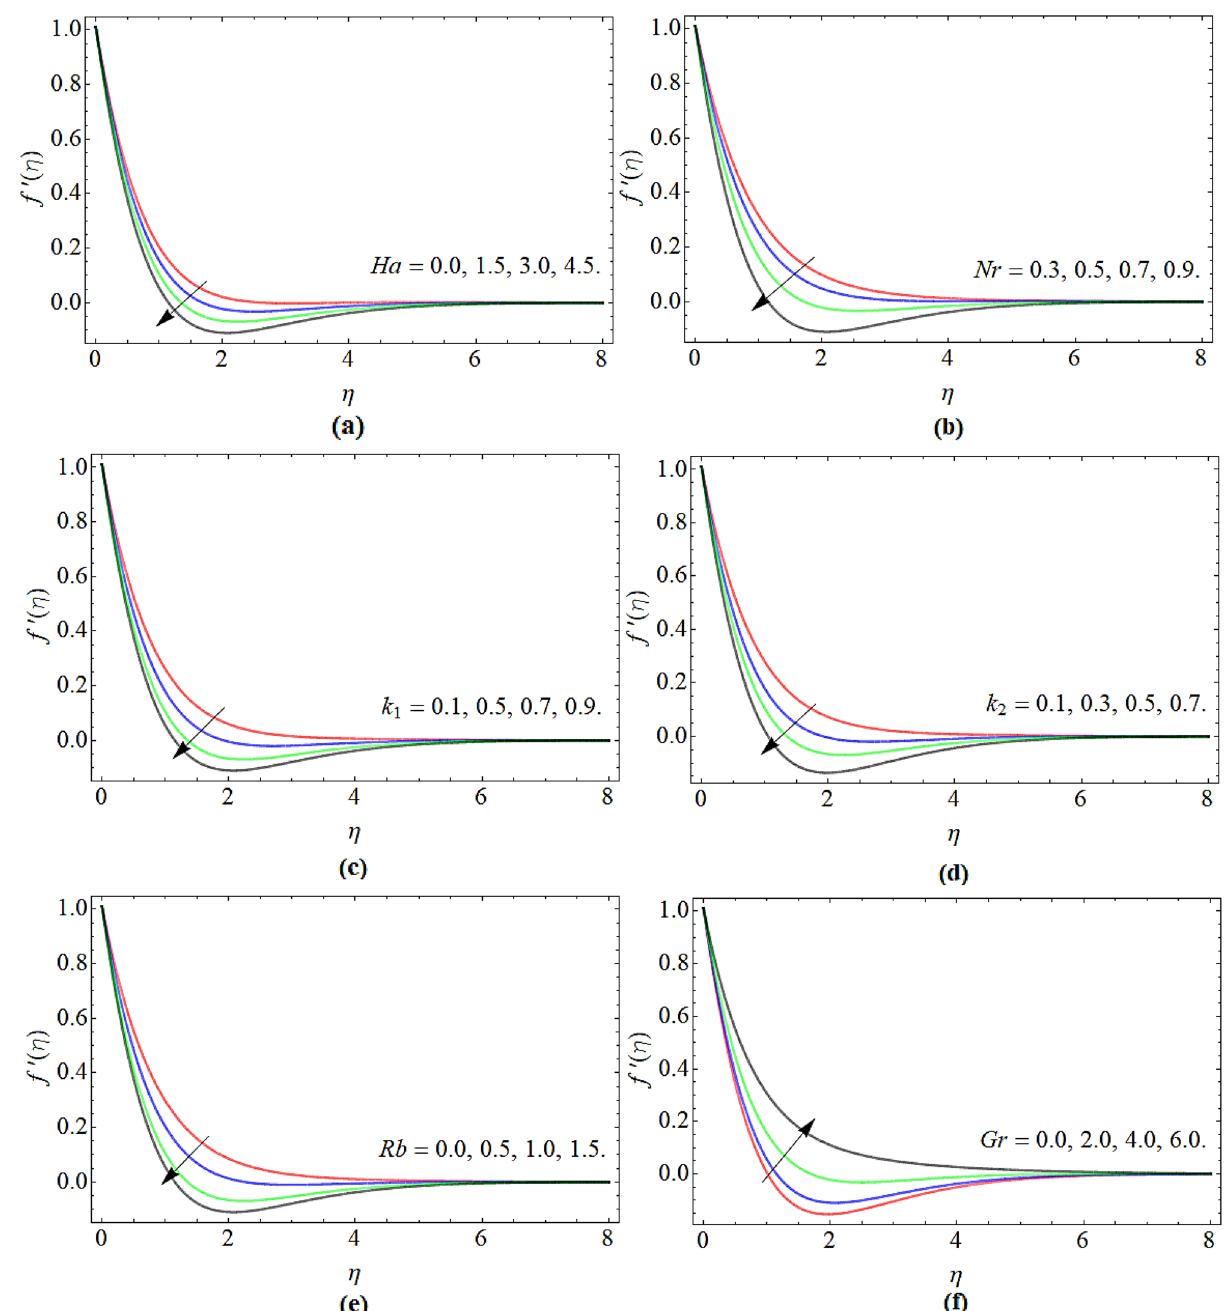
Figure 2. The nature of velocity f ′ (η) profile as opposed to ( a ) Hartmann number Ha , ( b ) buoyancy ratio Nr